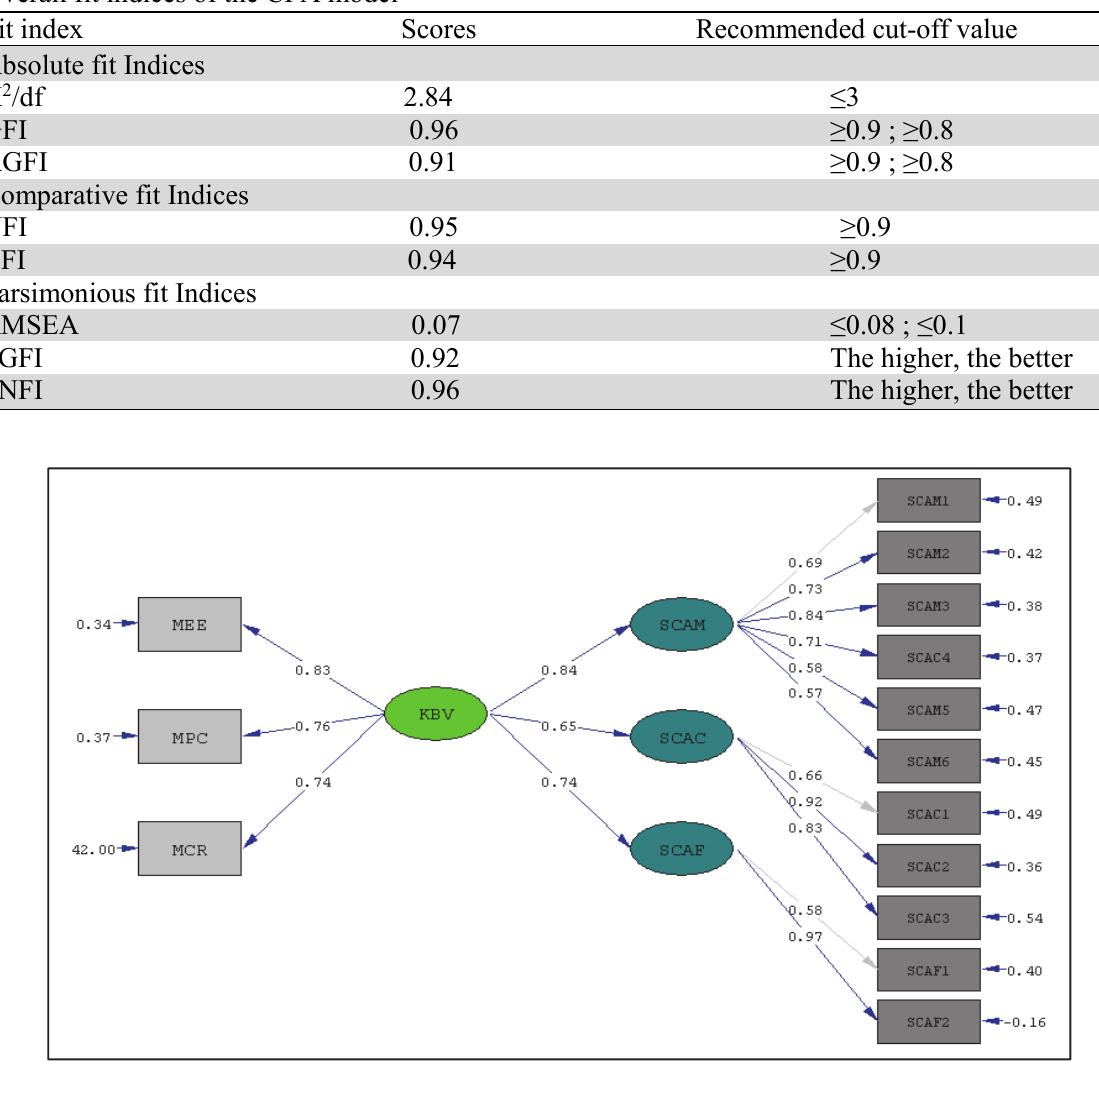
Fig. 3. Structural Relationship model between KBV and